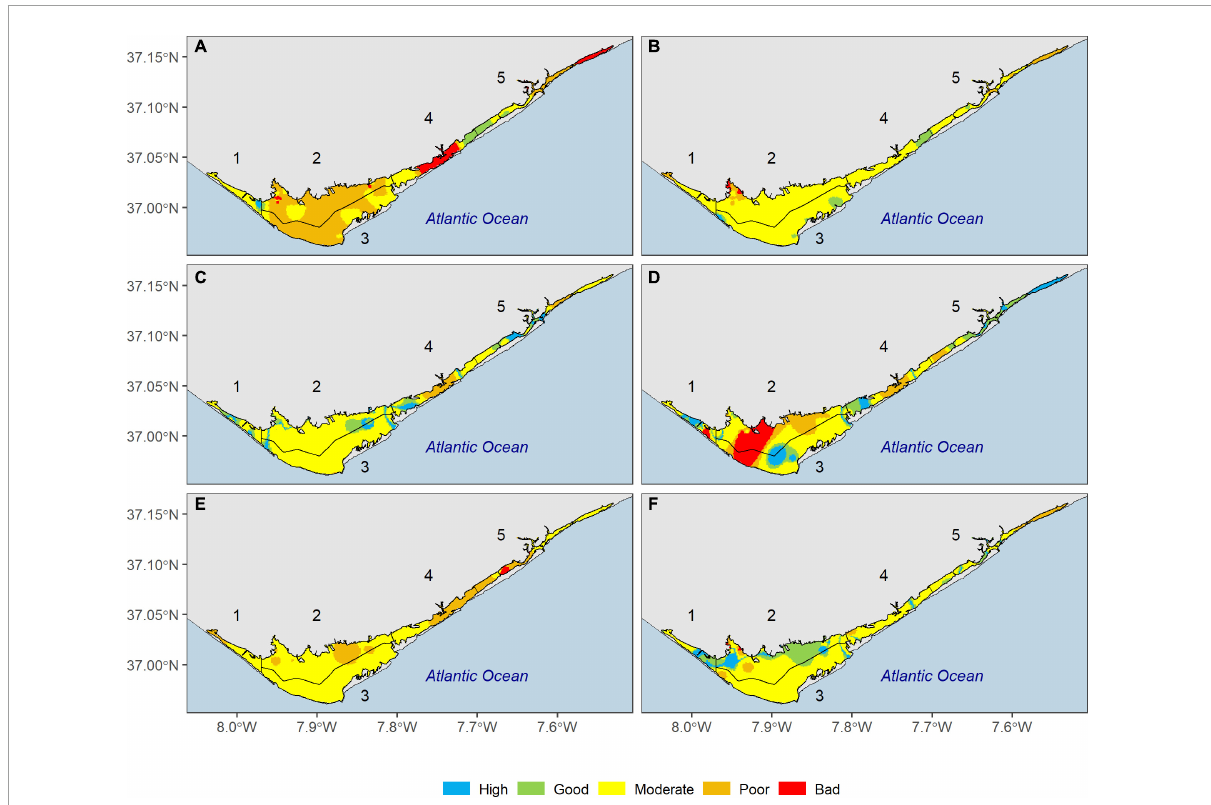
FIGURE4 Spatial distribution of Ecological Status categories: (A) DIN-Dissolved Inorganic Nitrogen (Ammonium, Nitrite and Nitrate); (B) DIP-Dissolved Orthophosphate; (C) N:P; (D) N:Si; (E) Chlorophyll a ; (F) Dissolved Oxygen (% saturation). The numbered polygons are the proposed water bodies from Ferreira et al.